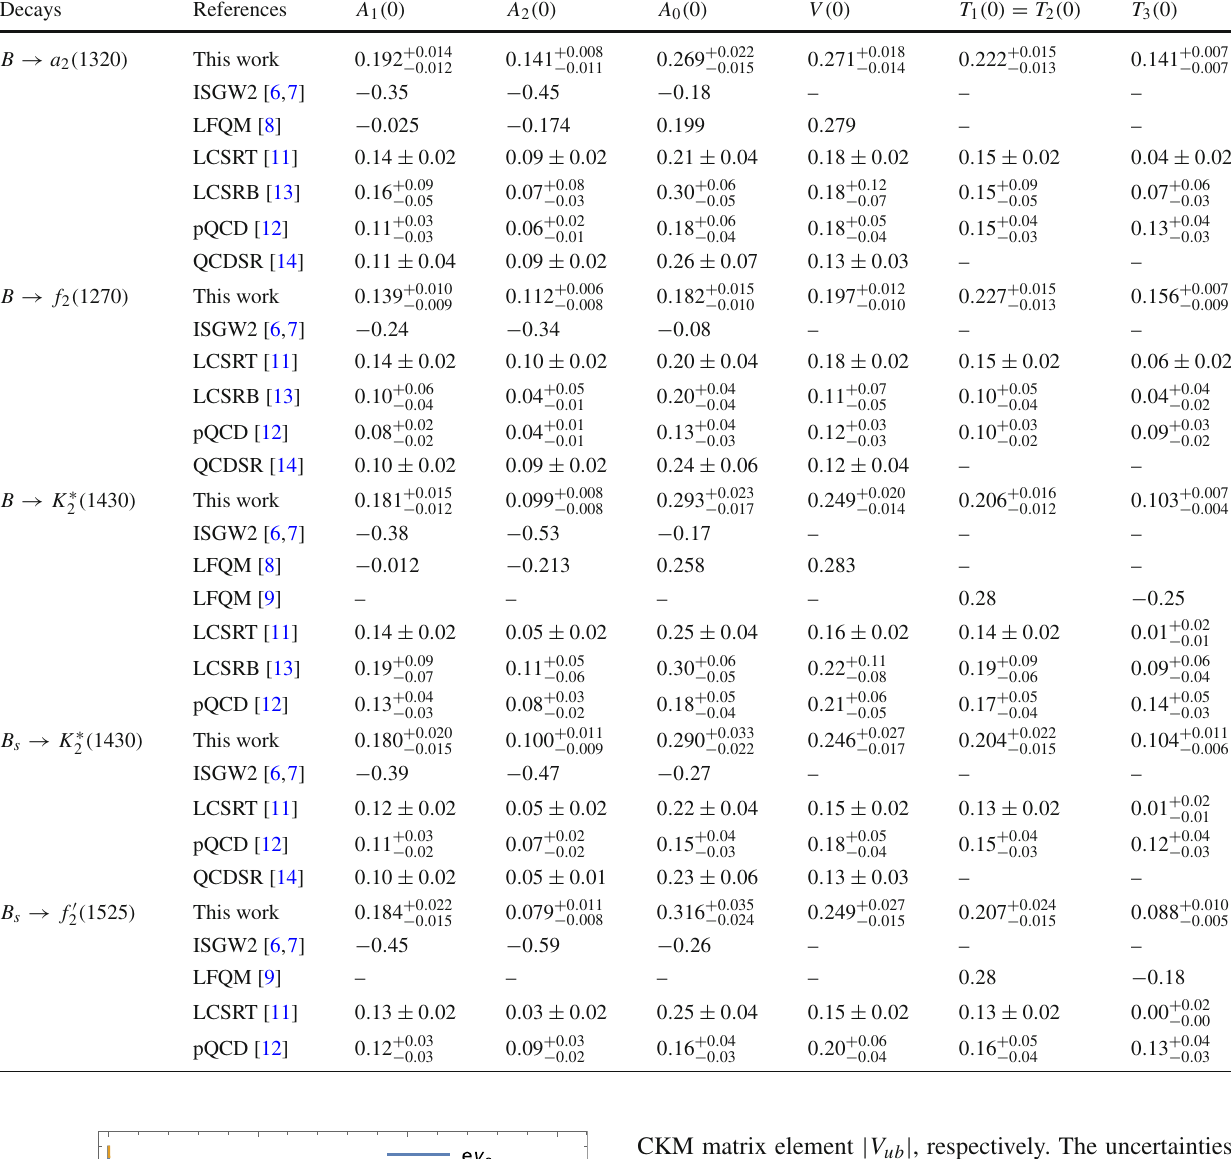
Table 4 Comparison of the B ( s ) → T form factors at q 2 = 0 given in this work with other groups. LCSRT and LCSRB denotes LCSR with tensor meson and B DAs, respectively